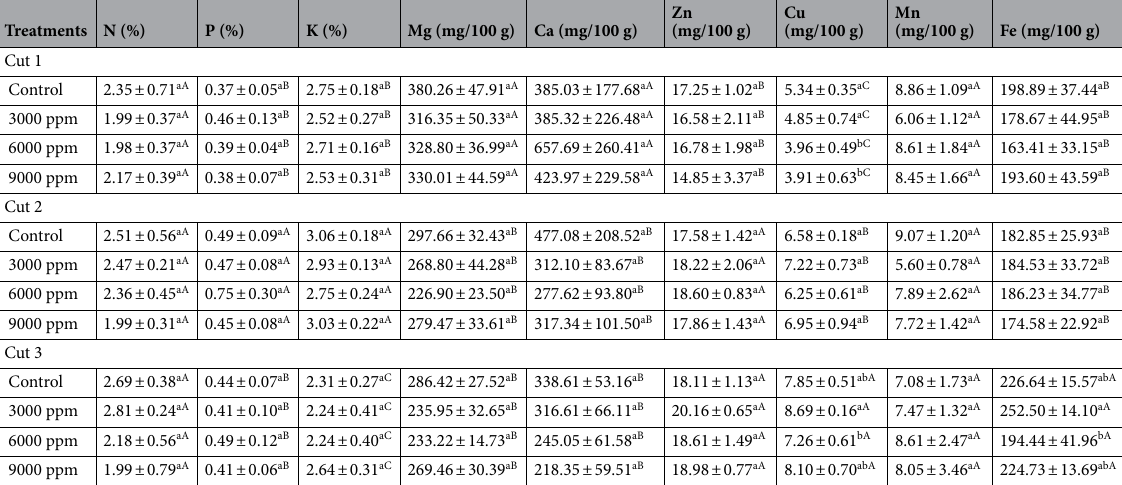
Table 8. Macro and micro-elements in kale leaves cultivated under freshwater and different salinities (3000 ppm, 6000 ppm, and 9000 ppm) at different cutting time points. Data expressed as mean ± SD (n = 3). N nitrogen, P phosphorus, K potassium, Mg magnesium, Ca calcium, Zn zinc, Cu copper, Mg manganese, Fe iron. Different lower superscript letters within the same column at the same cutting time point indicate a significant difference within the treatments at p < 0.05. Different upper superscript letters within the same column indicate a significant difference between the cuts at p < 0.05.